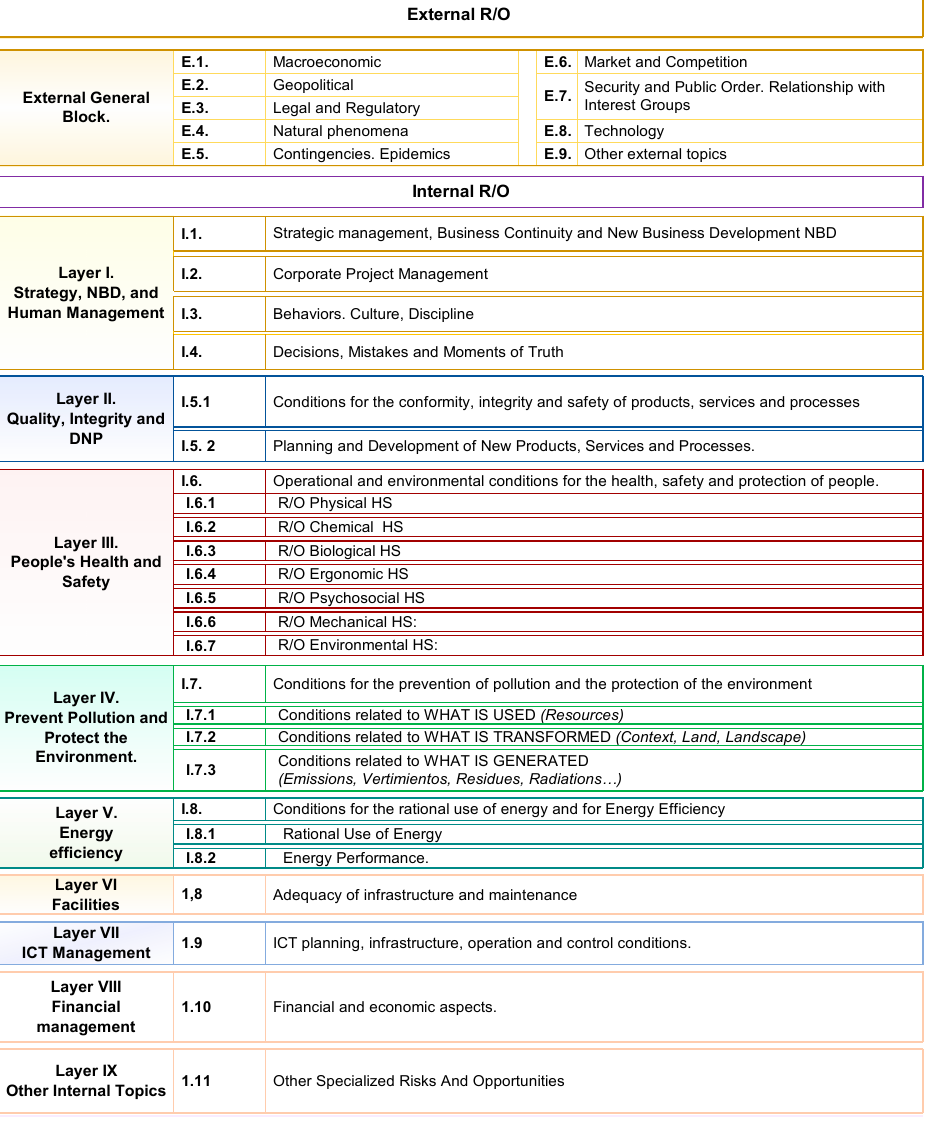
12 of 44 Figure 5. Integration of the logical structure of the requirements of CMS QHSE3+. Perspective of Application to Comprehensive Biosafety Management [25–31,86–90]. The ISO 50001: 2018 standard also includes particular requirements identified with the green letter petroleum ( E2 ), the numerals: 6.3 energy review, 6.4 energy performance, 6.5 energy baseline,